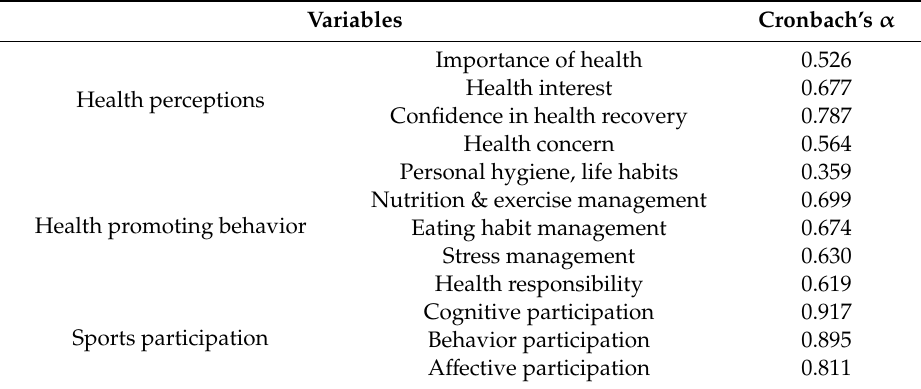
Table 2. Reliability